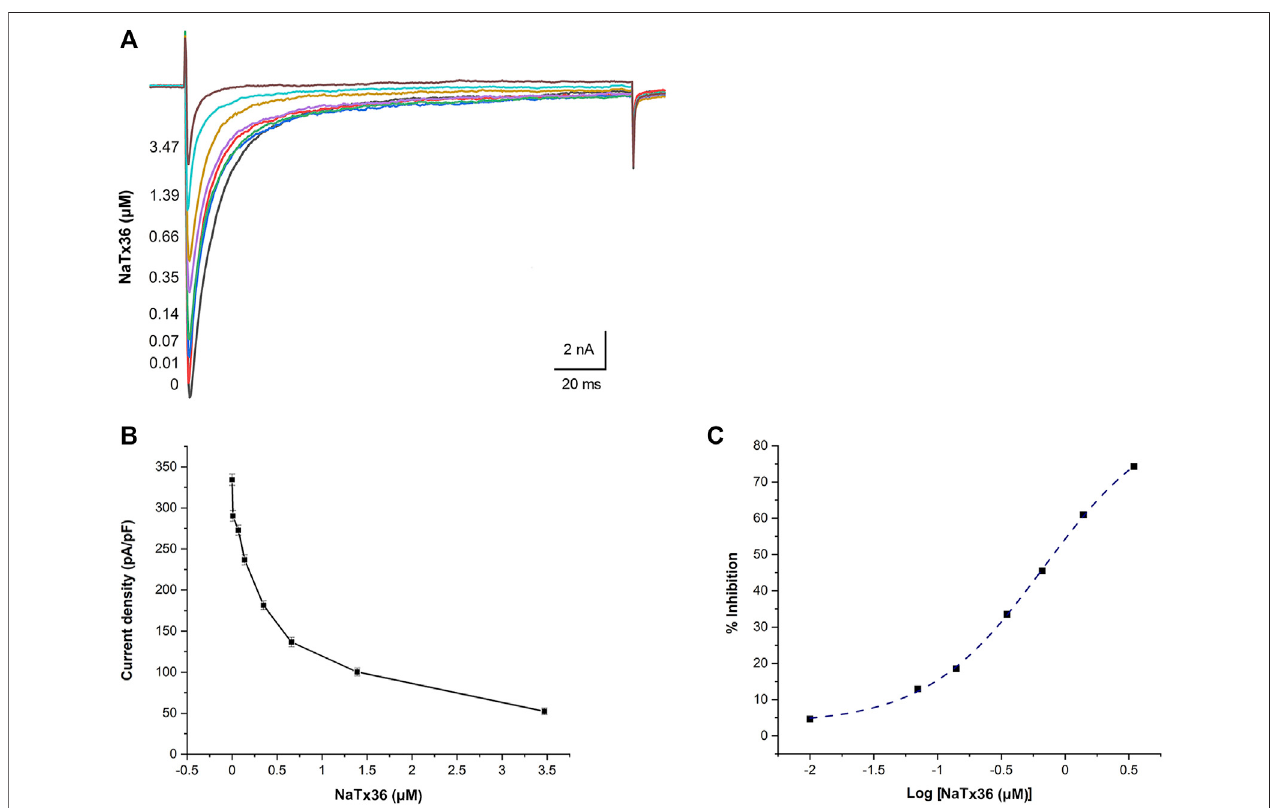
FIGURE 3 | NaTx36 inhibits OtNa V 1.8 in a concentration dependent manner. (A) TTX-R Na + current traces and (B) current density (pA/pF) recorded from ND7/23 cells expressing OtNav1.8 before and after application of NaTx36. Na + currents were elicited by a 100-ms depolarization to +20 mV from a holding potential of − 80 mV beforeandafter application ofNaTx36. Tetrodotoxin(TTX,500 nM)wasaddedtothebath solutiontoblockendogenousTTX sensitive Na + currents.Currentsdecrease inresponsetosamplesofNaTx36rangingfrom0.01to3.47 µM( n =5 – 6cellsperconcentration). (C) Na + currentvaluesinresponsetoNaTx36were fi ttoaDose- response equation with variable Hill slope to estimate the half-maximum inhibitory concentration (IC 50 = 0.68 ± 0.05